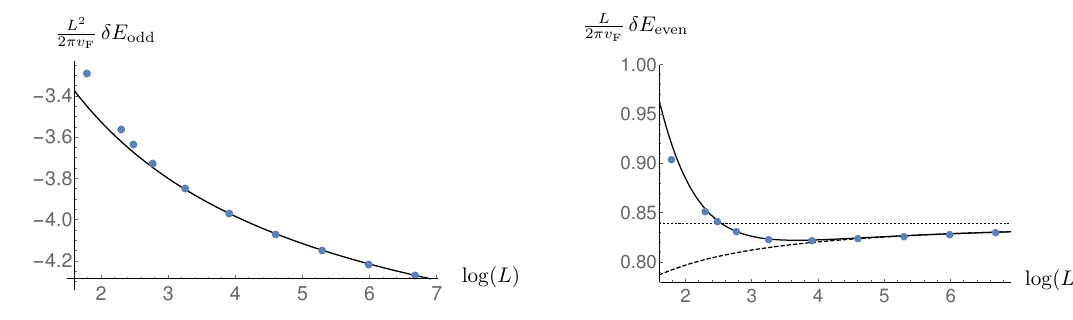
Figure 13. The points represent numerical data for (cid:14)E odd (cid:17) E (+) (cid:0) E ( (cid:0) ) and (cid:14)E even (cid:17) E (+) + E ( (cid:0) ) (cid:0) v F e 1 L , which was computed using the Bethe roots for the state (cid:13)owing to the conformal descendent with dimensions ( (cid:22)(cid:1) ; (cid:1)+1). The typical pattern of roots for this state is given in (cid:12)gure 10. On the left panel, the solid line is the prediction coming from the (cid:12)nite size corrections eq. (85). On the right panel, the asymptotic formula (86) with only the L (cid:0) 1 term included is displayed by the dashed line, while the solid line takes into account the L (cid:0) 3 correction. The limiting value lim L !1 L (cid:14)E even = 0 : 839583 : : : is shown by the dotted line. Finally s ( L ), which is needed 2 (cid:25)v F